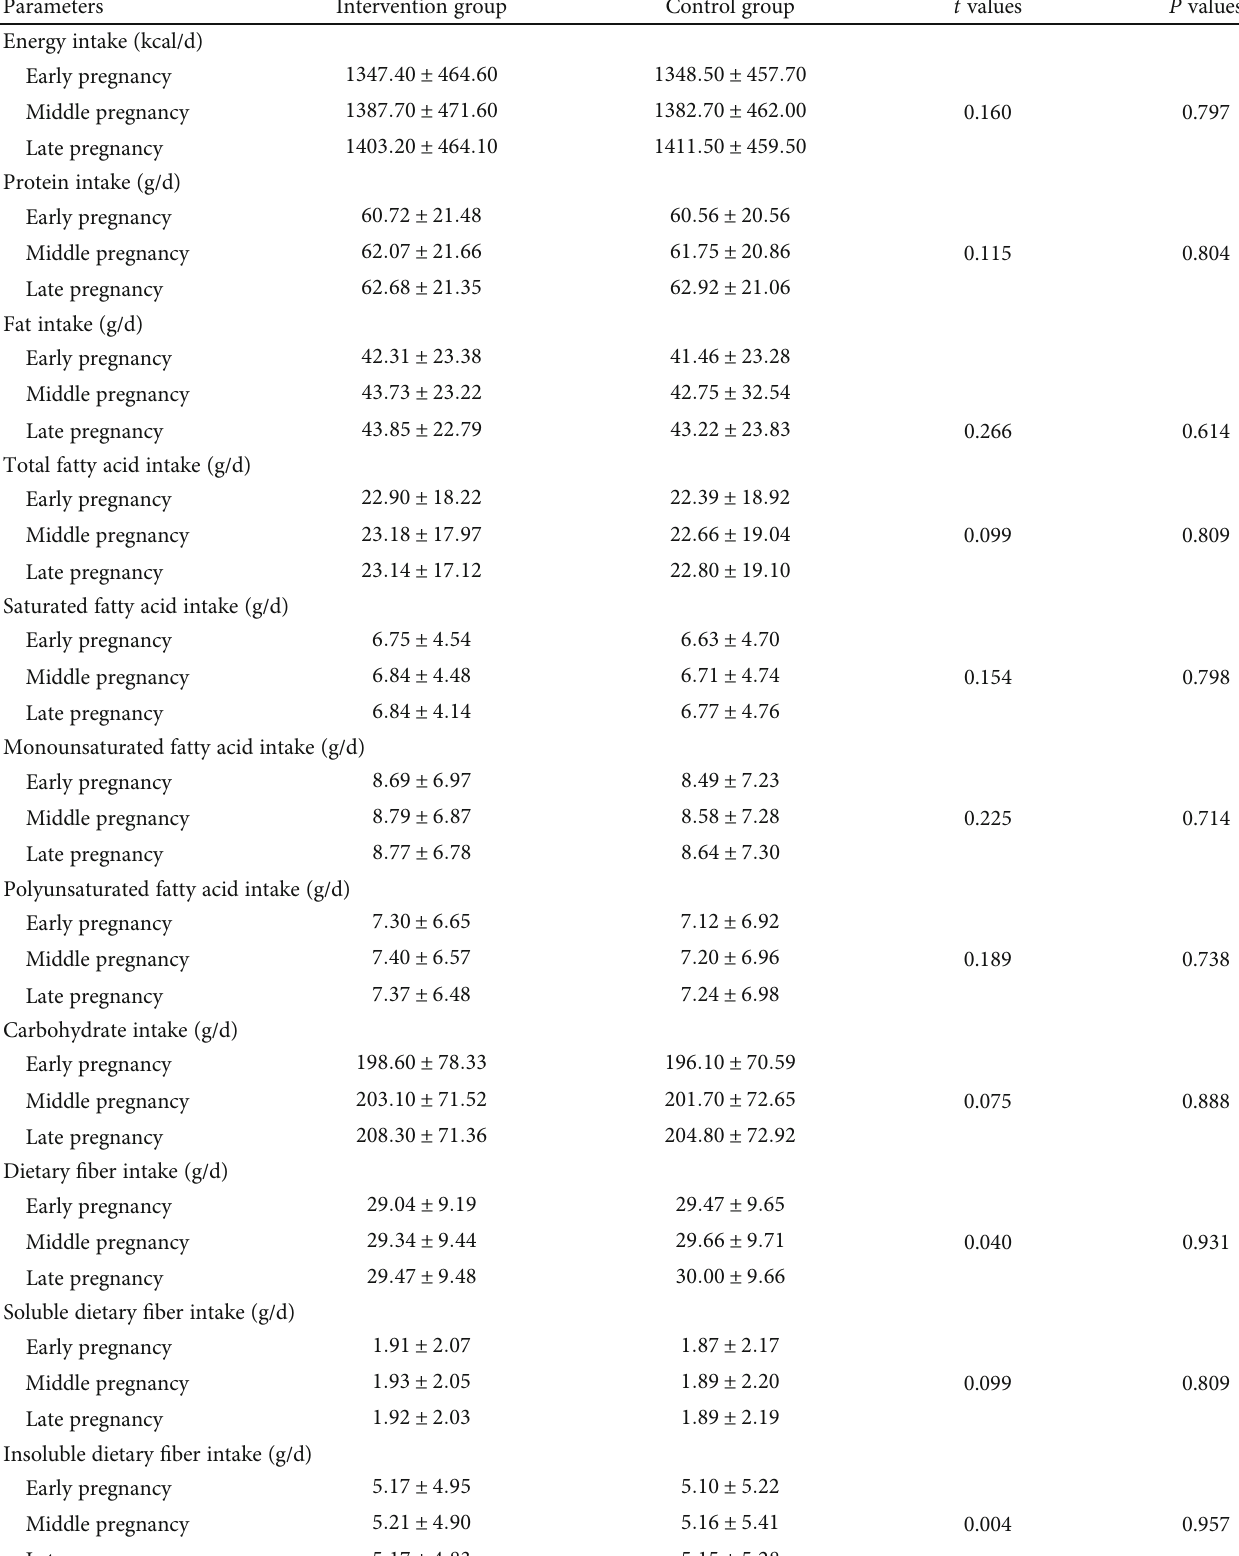
Table 5: Dietary energy and main nutrient intake of pregnant women in di ff erent periods. Parameters Intervention group Control